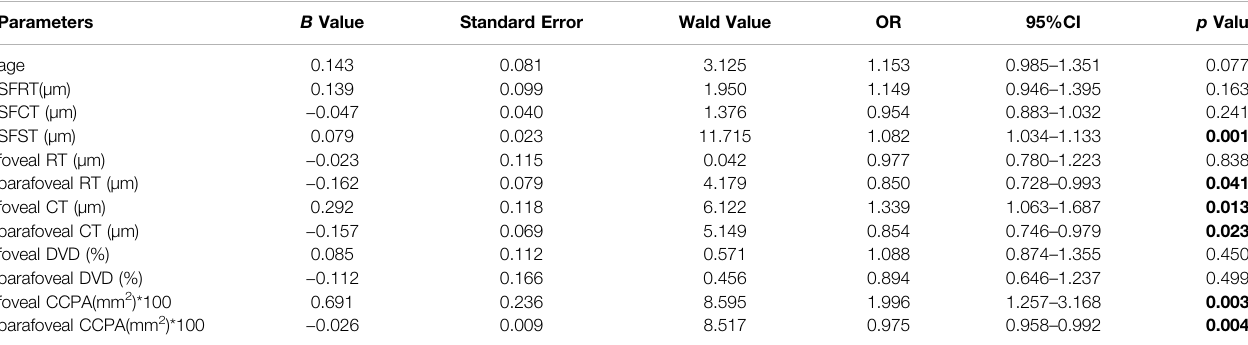
TABLE 4 | Analysis of correlations between PS and variables by generalized estimating equation.